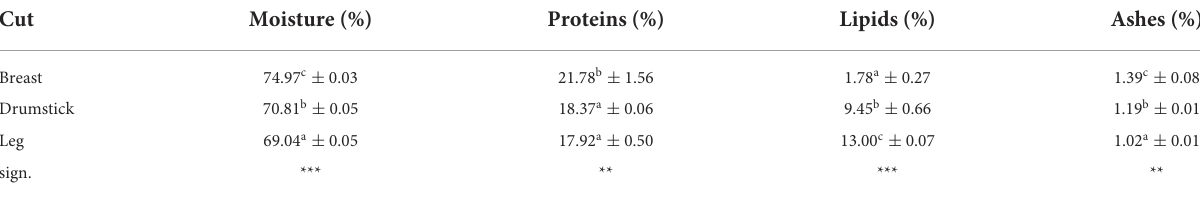
TABLE 1 Proximate composition (%) of three cuts of chicken meat (without skin).